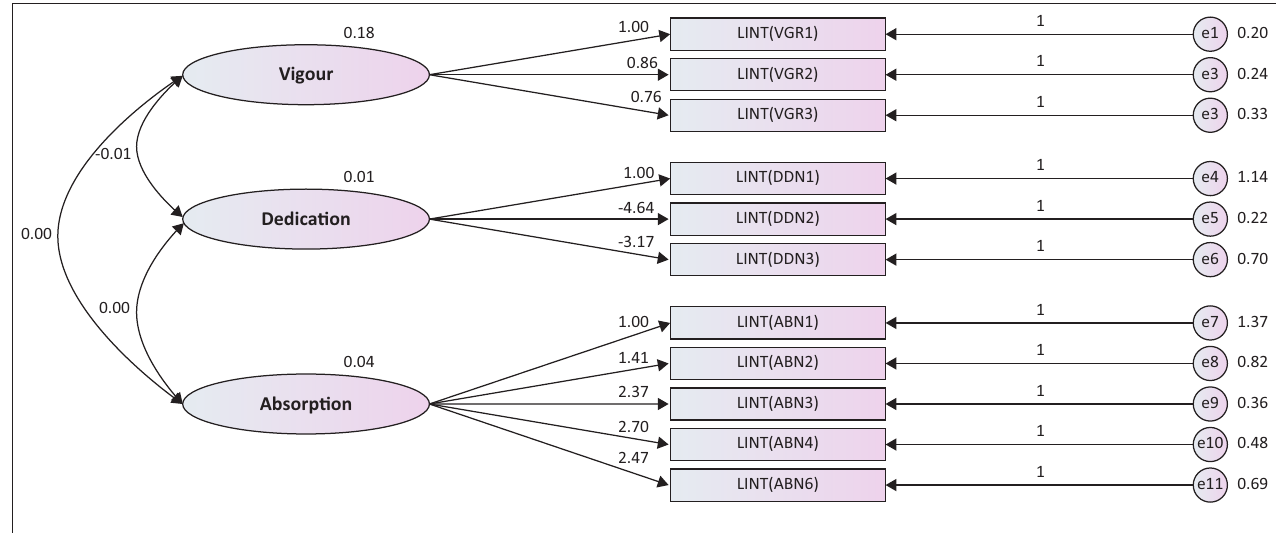
FIGURE 3: Tri-factor Utrecht Work Engagement